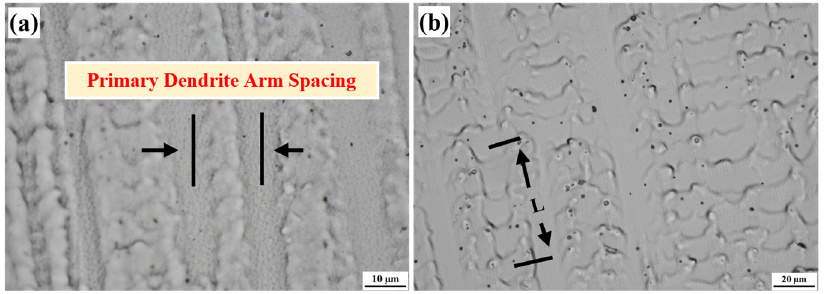
Figure 5. Microstructure morphology in cross-section (y–z plane) of the as-fabricated sample with heat input 828 J/mm. ( a ) Illustration of microstructure observing position. ( b – i ) Representative microstructure at low and high magnifications for different positions: ( b , f ) the last layer, ( c , g ) top region, ( d , h ) middle region and ( e , i ) bottom region.